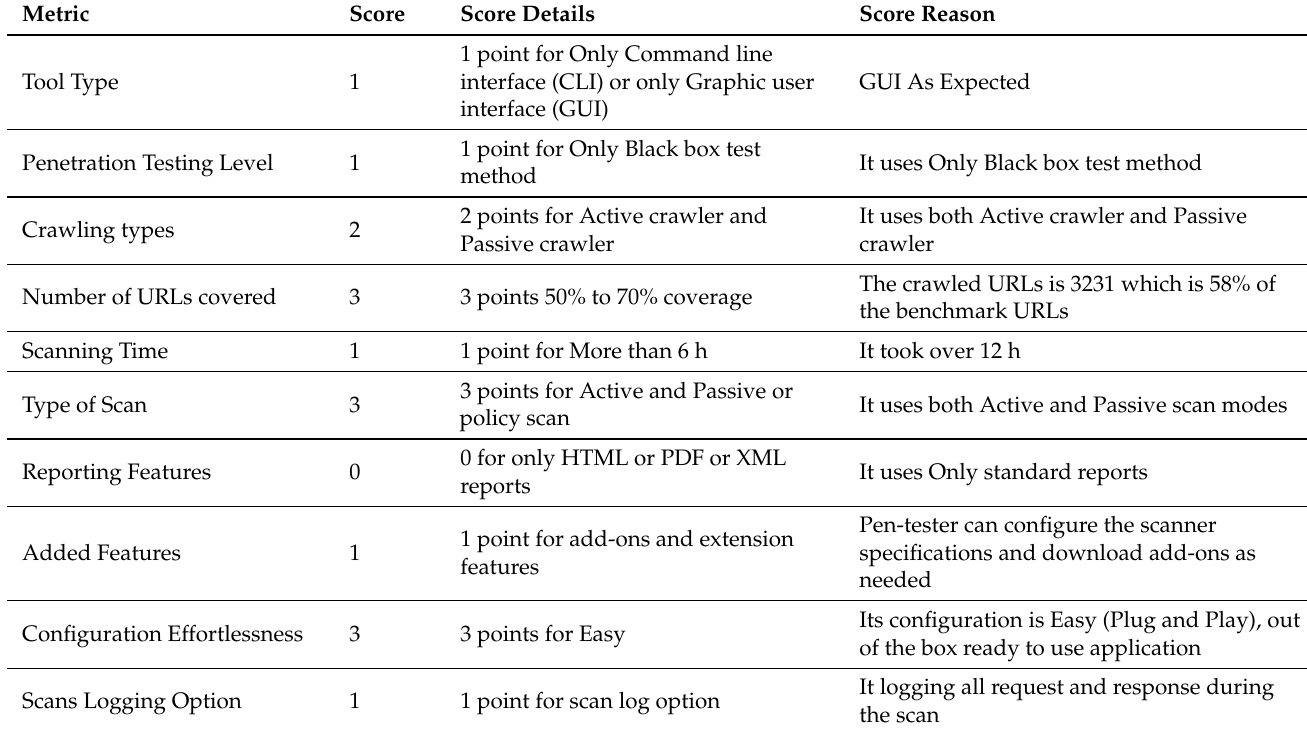
Table A2. Results of benchmarking Burp Suite Professional using our framework in